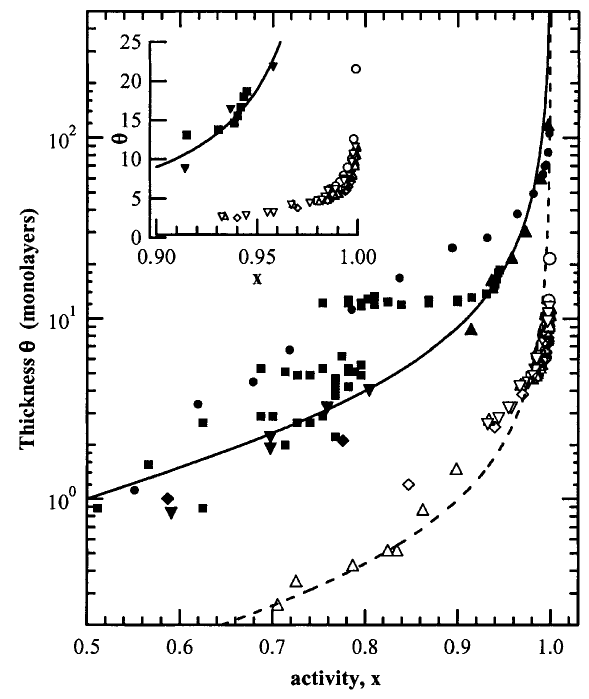
der of 90 Km − 1 . The size of each image is 3.6mm × 1.8mm ×